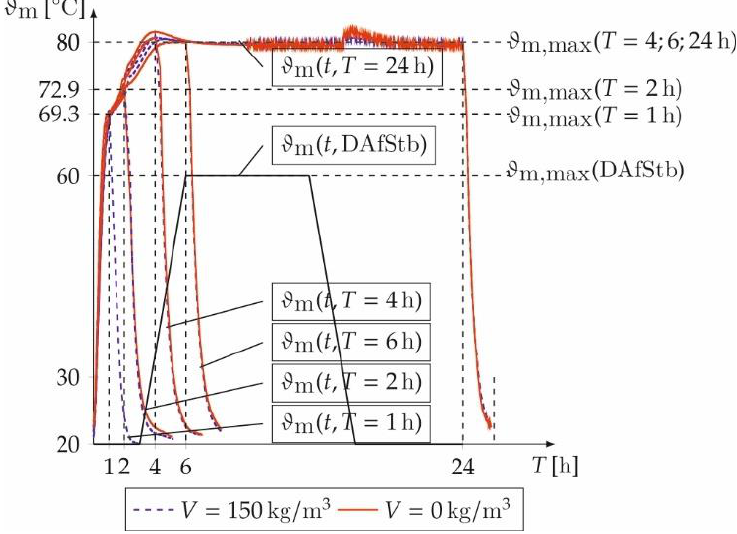
Figure 3. Core temperature ϑ m of the prisms with and without fibres as well as the annealing regime according to [25].